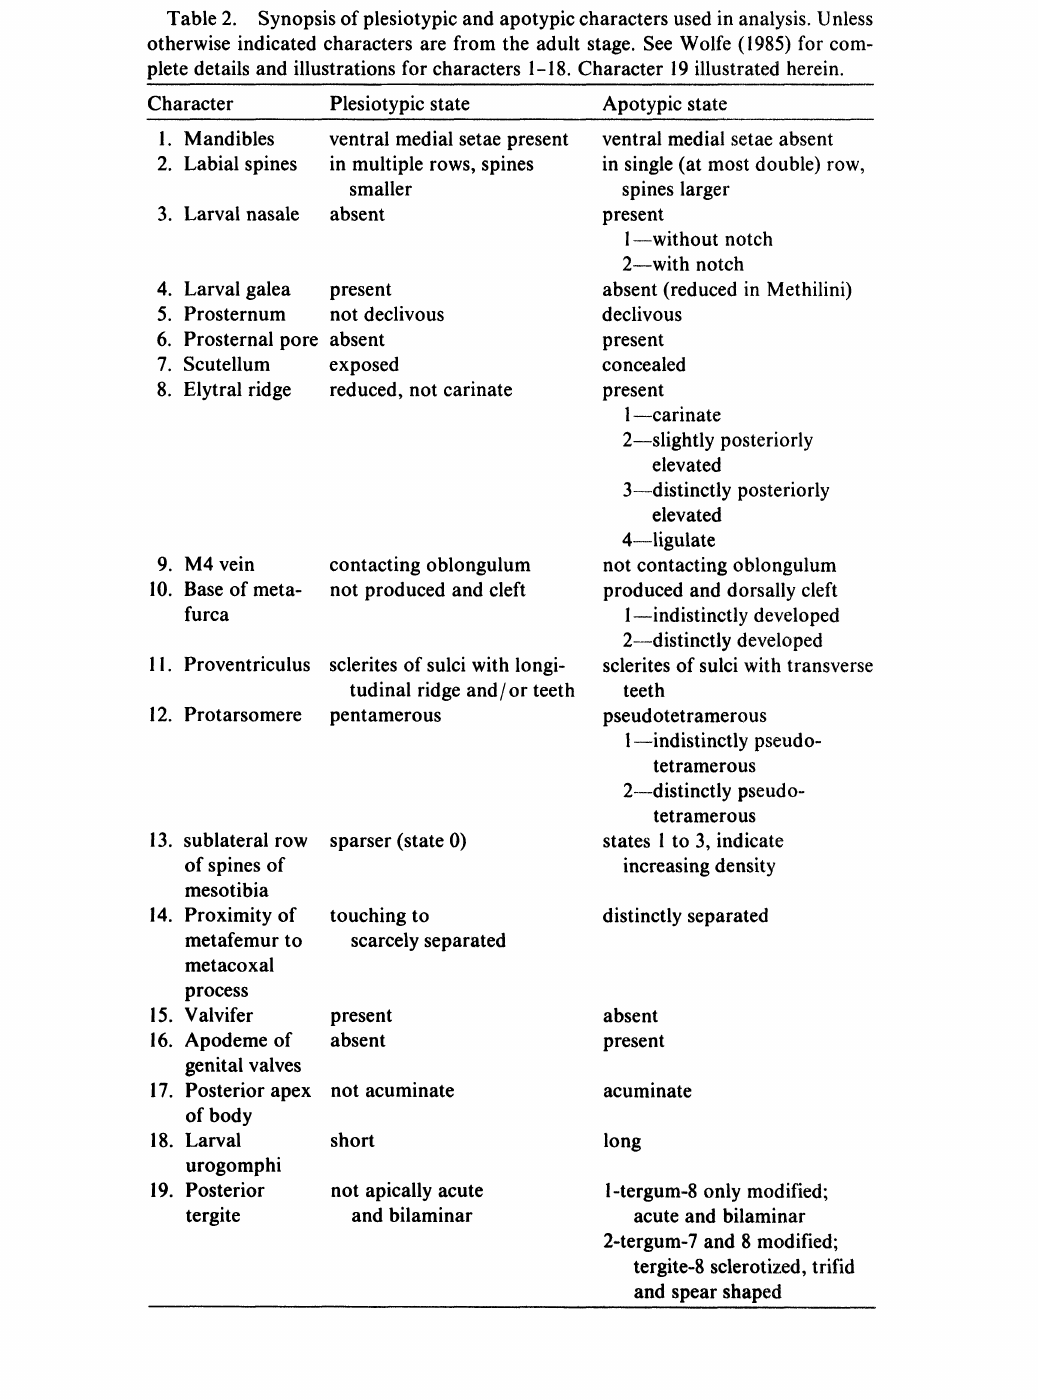
Table 2. Synopsis of plesiotypic and apotypic characters used in analysis. Unless otherwise indicated characters are from the adult stage. See Wolfe (1985) for com- plete details and illustrations for characters 1-18. Character 19 illustrated